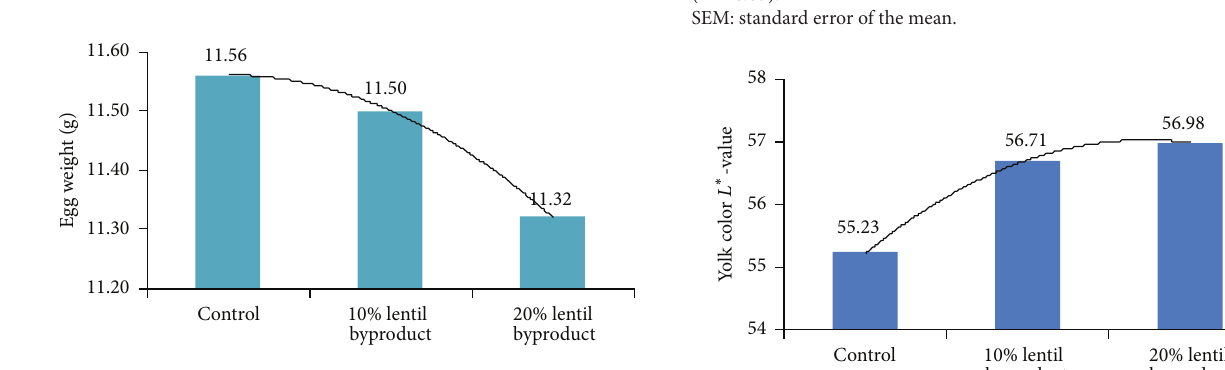
Figure 3: Effect of lentil byproduct on egg weight.